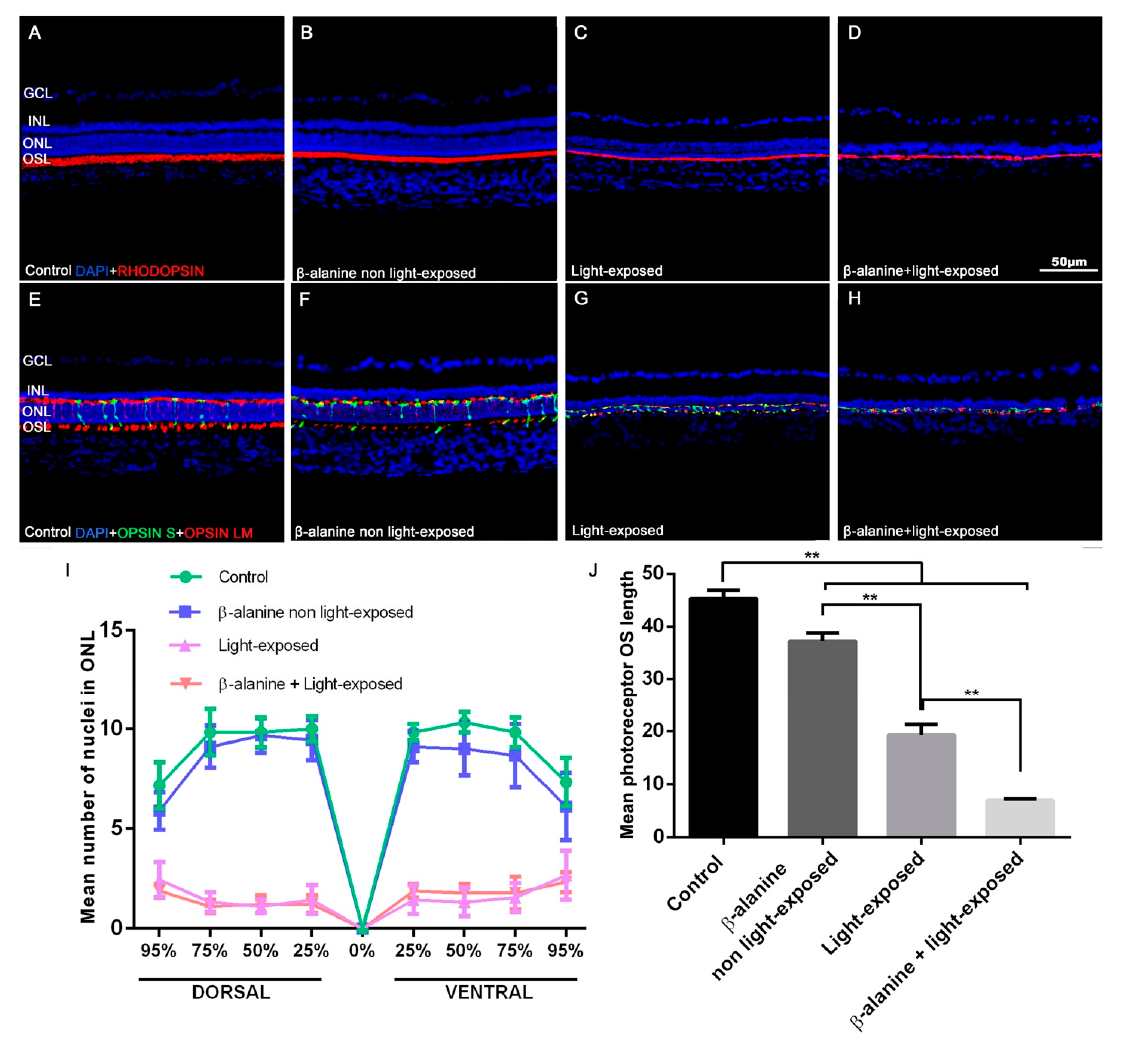
Figure 3. Photoreceptor outer segment morphology. Photomicrographs of retinal cross sections taken from representative animals of the different subgroups: control ( A , E ), β -alanine non light exposed ( B , F ), light-exposed ( C , G ) and β -alanine and light-exposed ( D , H ), showing rhodopsin (red, A – D ), S (red, E – H ) and L/M- (green, E – H ) opsin immunoreactivity and nuclear DAPI counterstaining (blue, A – H ). Rod and cone outer segments (OS) show reduced length in the experimental subgroups. The photoreceptor OS layer show reduced thickness in the experimental subgroups. Graphs showing mean numbers ± SD of ONL nuclei rows ( I ) and the mean thickness ± SD of OS layer ( J ) in the different subgroups. Scale bar: 50 µ m. n = 10 per subgroup analyzed. ** Significant differences when compared to other subgroups ( p ≤ 0.001). GCL: Ganglion cell layer. INL: Inner nuclear layer. ONL: Outer nuclear layer. OSL: Outer segments